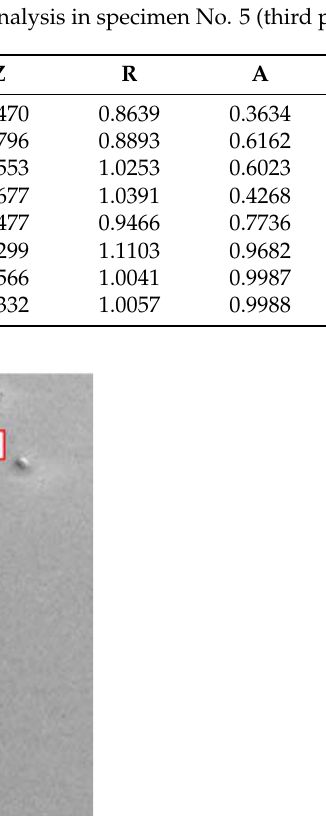
Figure 16. SEM image of specimen No. 5 with marked regions of compositional analysis to study the lack of fusion defect.